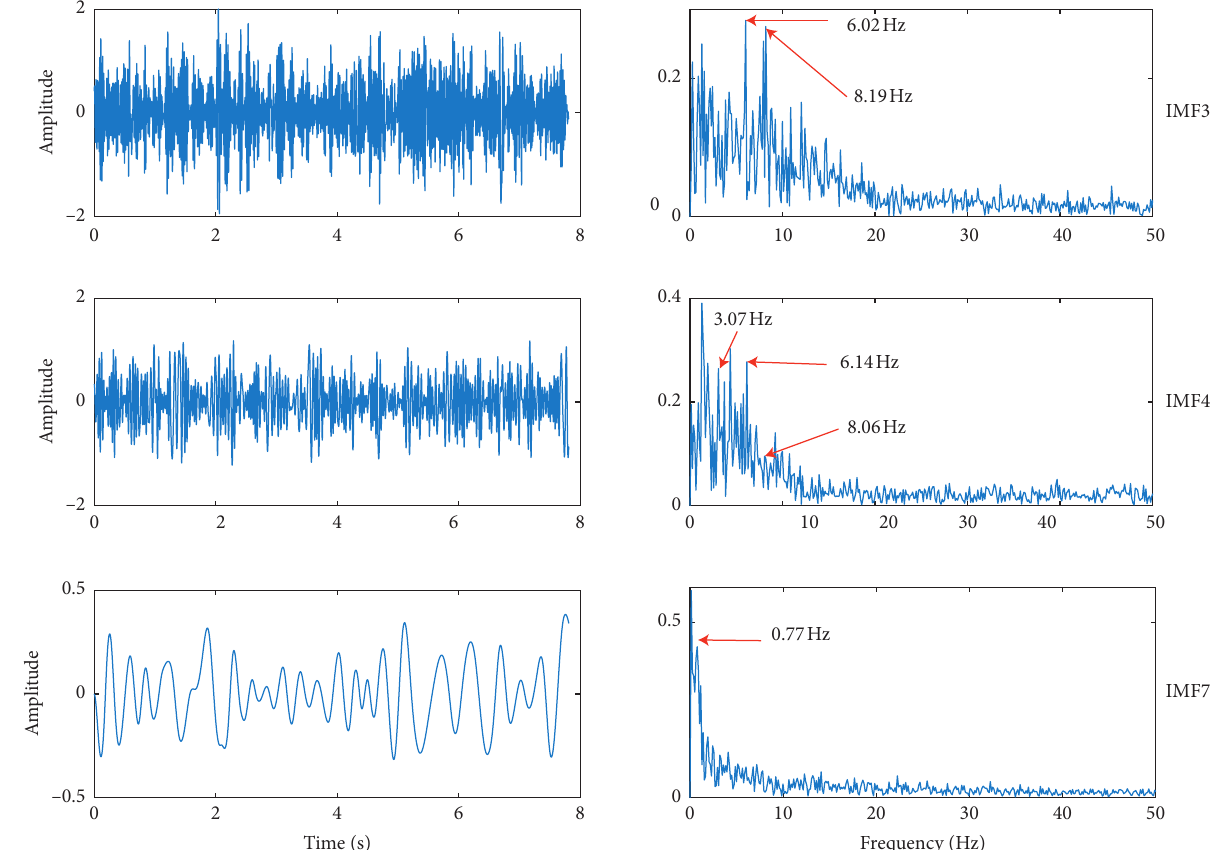
Figure 5: The optimal IMF selected according to the maximum T-SAF.